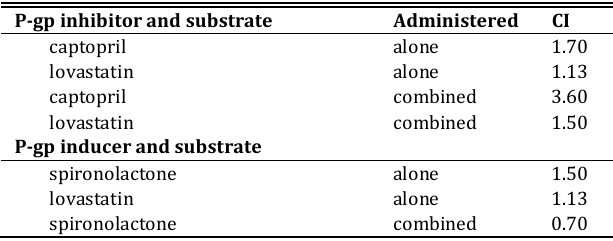
Table 5. Chronicity index of P-gp inhibitor and